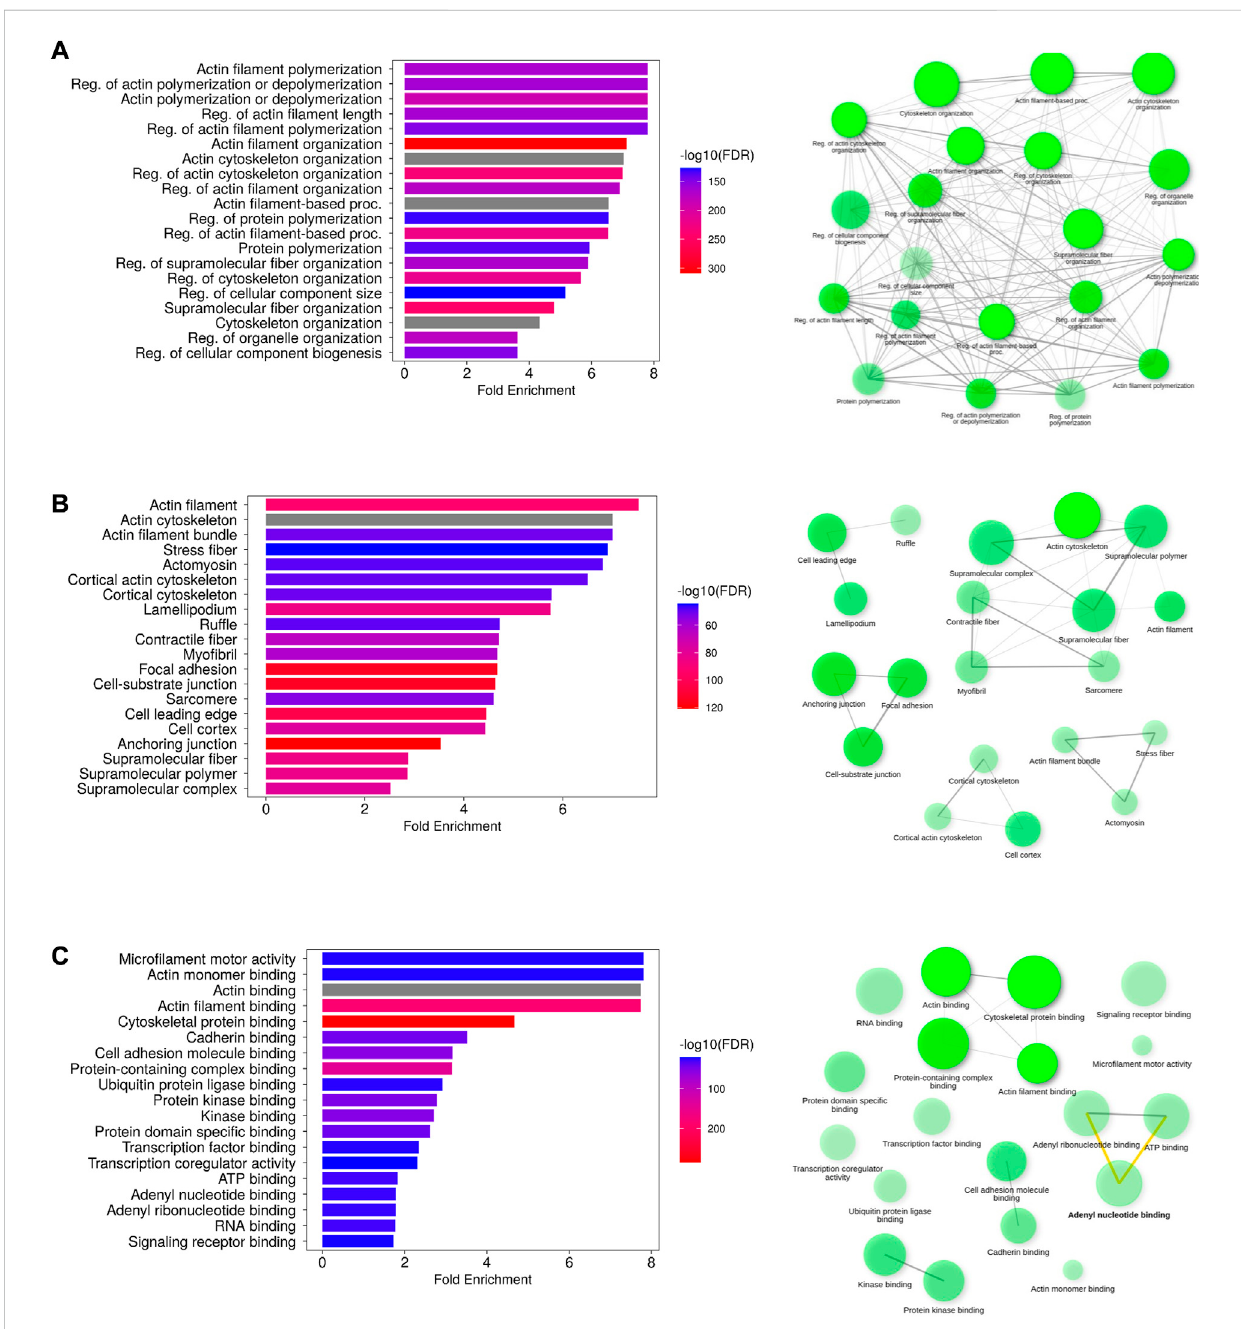
FIGURE 4 FunctionalanalysisofputativeAAPs.TheenrichedGOtermsrepresentingthebiologicalprocess (A) ,cellularcomponent (B) ,andmolecularfunction (C) have been depicted as bar plots. The network diagrams indicate theinterconnection betweenthe GO terms ineach category.The most enriched GO terms are actin fi lament polymerization/depolymerization (biological process), localized to the actin fi lament (cellular localization), and micro fi lament activity (molecular